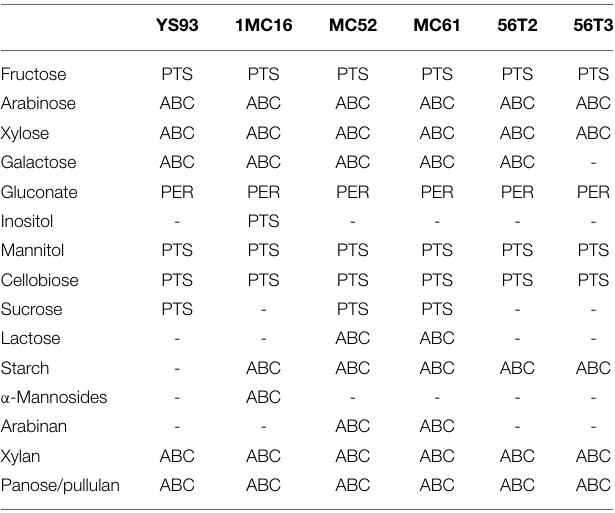
TABLE 11 | Summary of carbohydrate utilization